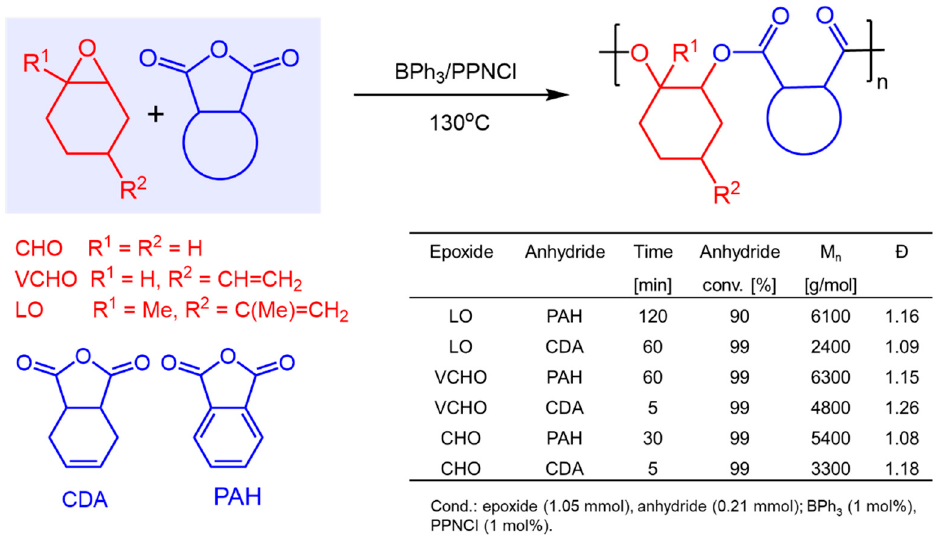
Figure 1. BPh 3 -catalyzed copolymerization of organic anhydrides and epoxides.